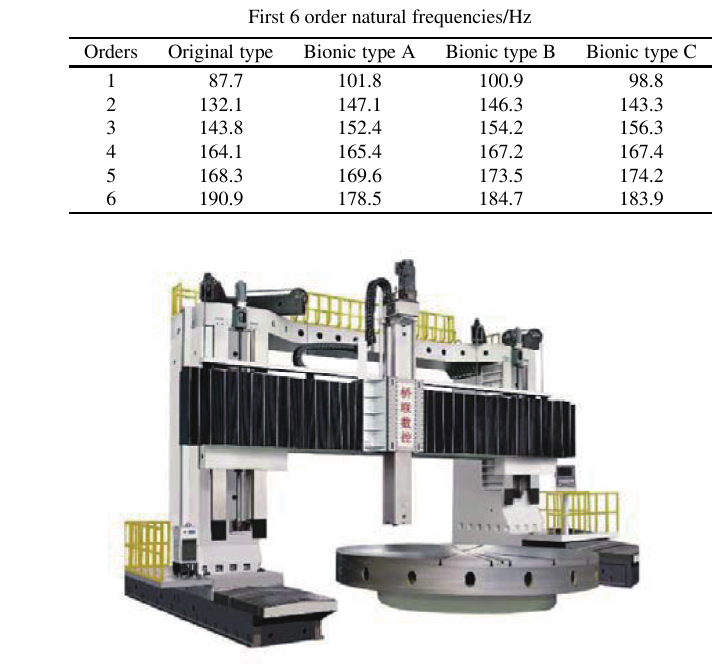
Fig. 13. Physical model of gantry machining